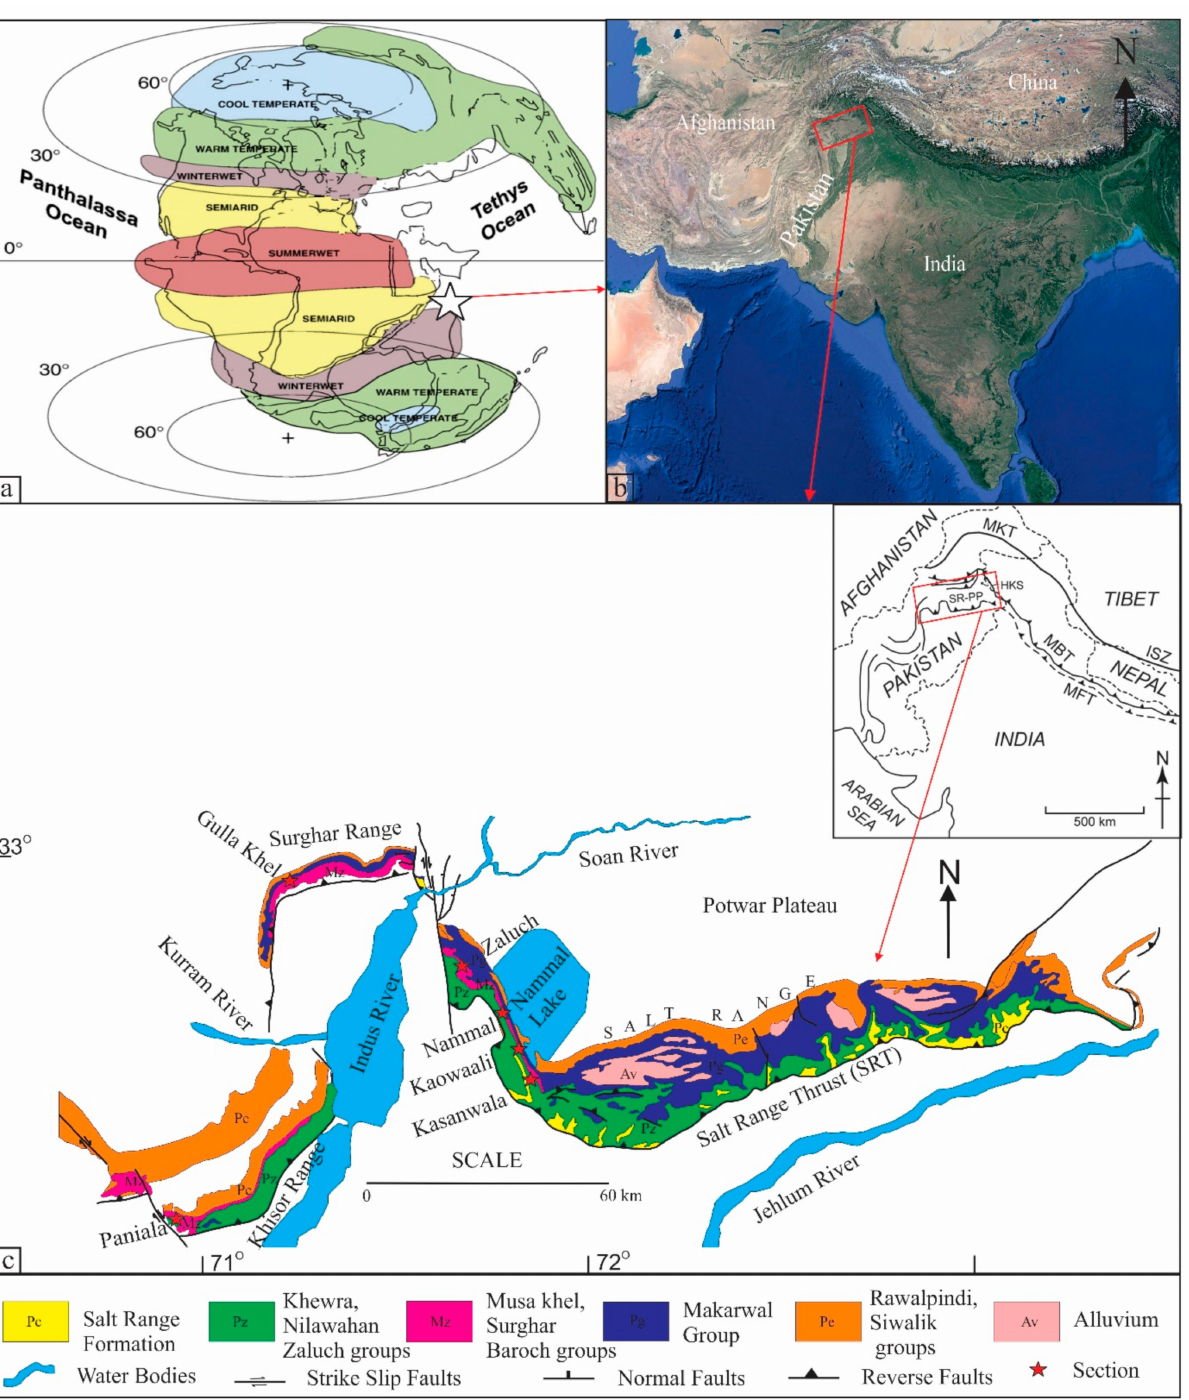
Figure 1. Current and palaeogeographic locations of the Salt Range, Pakistan. ( a ) Early Jurassic palaeogeographic location of the study area. The star marks location of the study area. ( b ) Google Earth view of Pakistan in regional context. The rectangle marks the location of Salt Range–Kohat–Potwar Plateau. ( c ) Salt and Trans–Indus ranges with locations of the studied sections. The inset map shows location of the Salt Range-Potwar Plateau (SR–PP) within the Himalayan orogenic belt. ISZ = Indus Suture Zone, MKT = Main Karakoram Thrust, HKS = Hazara-Kashmir Syntaxis, MBT = Main Boundary Thrust, MFT = Main Frontal Thrust (modified after